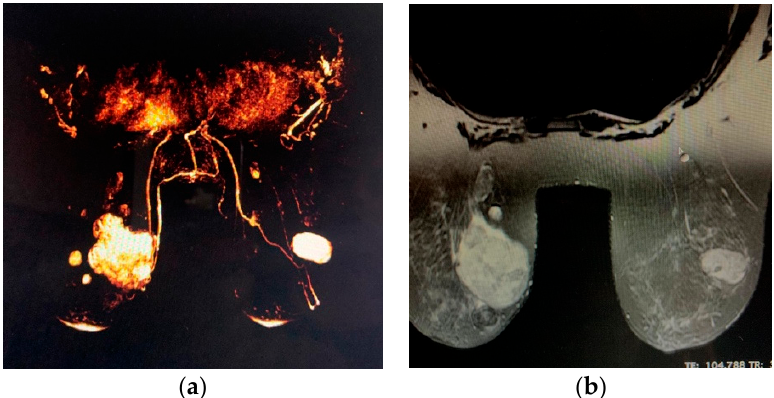
Figure 2. Giant tumor of the breast on magnetic resonance imaging (MRI), ( a ) three-dimensional (3D) reconstructions for lesion mapping, ( b ) the giant lesion at the intersections of the inner quadrants of the left breast has an inhomogeneous structure, with hyposignal zones, diffusion restriction and washout areas, and on the lower inner quadrant (LIQ) of the right breast, an area with benign tumor characteristics.